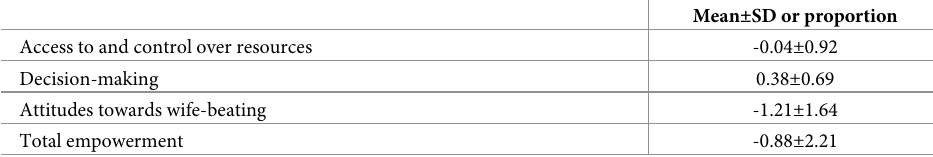
Table 2. Associations between maternal employment and child development, childcare practices, and women’s empowerment 1 .